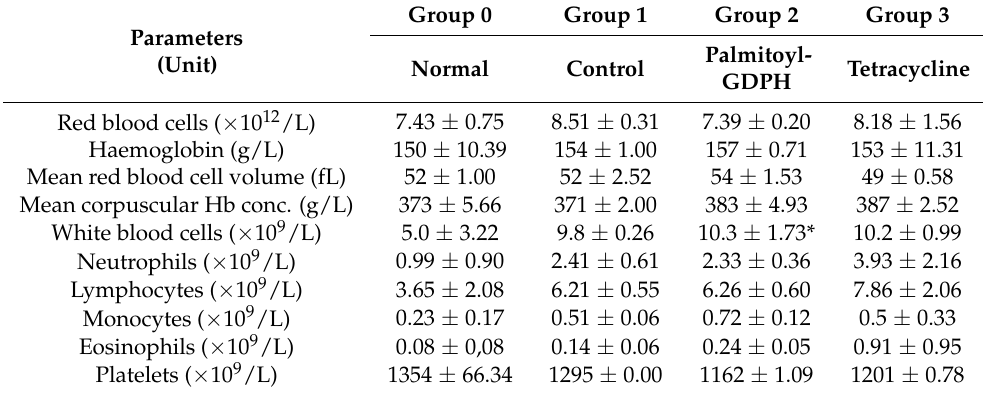
Table 4. Hematology analysis data for individual types of blood cells. Values are expressed as mean ± SD. The asterisks (*) represent significant difference (* p < 0.05) from normal group.